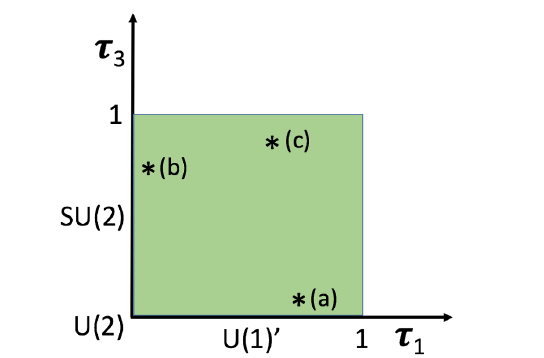
Figure 3 . Region M /G for the U(2) model. The green area highlights the domain where an expansion in powers of τ 1 . 3 is meaningful. The stars marked ( a ) , ( b ) and ( c ) would suggest vicinity to phase transitions where the unbroken groups are U(1) 0 , SU(2) and U(2) ,